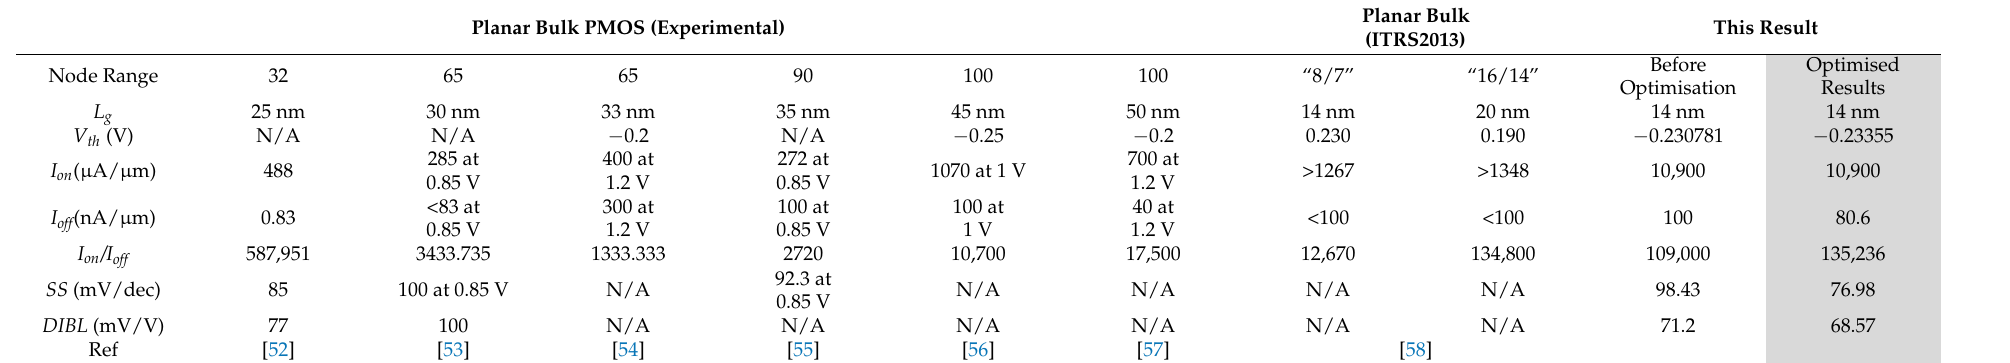
Table 5. Comparison of different gate-length planar bulk PMOS values vs. ITRS.